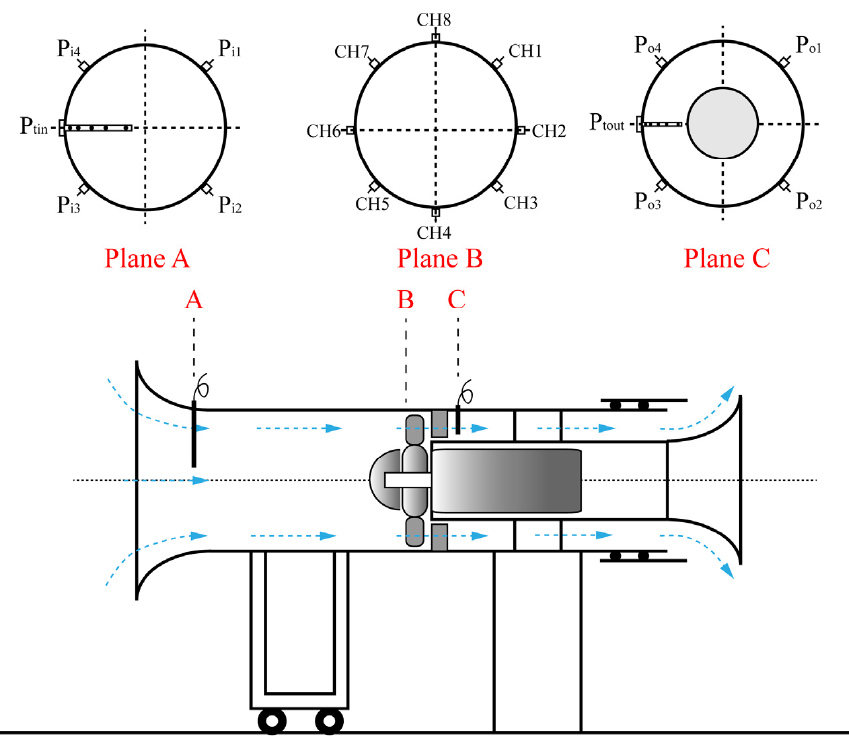
Figure 1. Schematic of TA 36 and measurement sections.